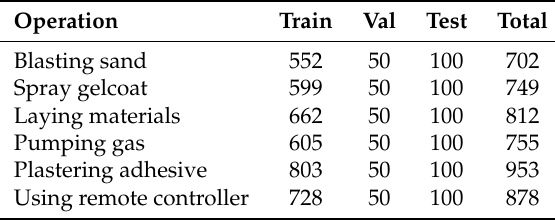
Table 1. The amount of video data for each operation and the partitioning